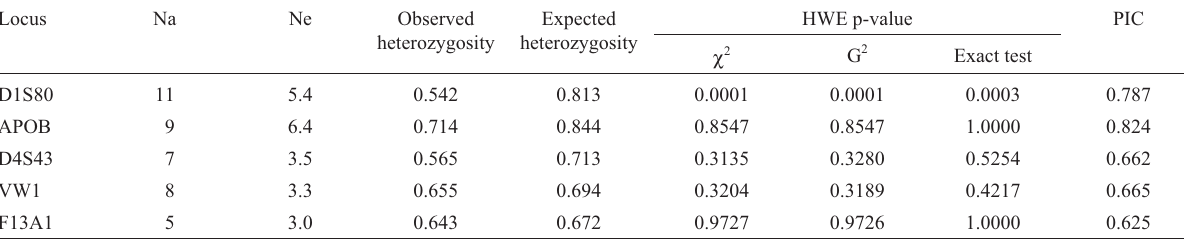
Table 3 - Statistical parameters for autosomal loci in the Pacoval